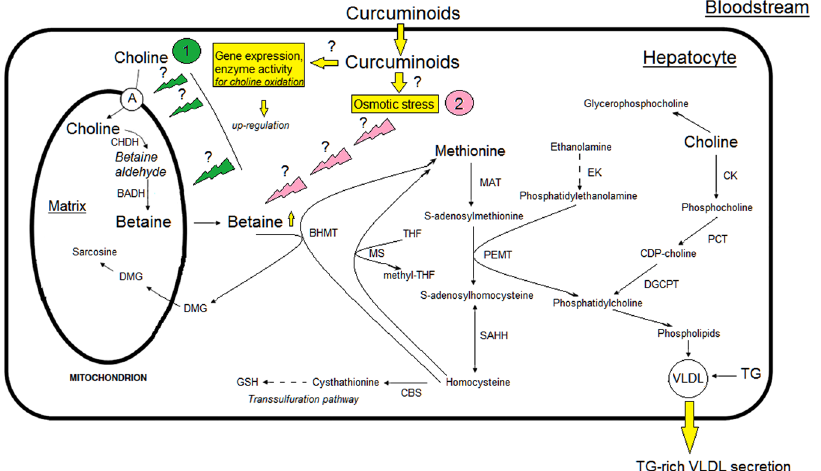
Figure 3. Overview of the metabolism of hepatic methylamine. (1) Choline oxidation pathway, the up regulation of gene expression and/or enzyme activity involved in this pathway. (2) Osmotic stress pathway by which curcuminoids might downregulate the BHMT enzyme activity in liver leading to high level of betaine. Choline transporter (A); choline dehydrogenase (CHDH); betaine aldehyde dehydrogenase (BADH); betaine homocysteine methyltransferase (BHMT); cystathionine β -synthase (CBS); choline kinase (CK); 1,2 diacylglycerol choline phosphotransferase (DGCPT); dimethylglycine (DMG); ethanolamine kinase (EK); methionine adenosyltransferase (MAT); methionine synthase (MS); phosphocholine cytidylyltransferase (PCT); phosphoethanolamine N-methyltransferase (PEMT); S-adenosylhomocysteine hydrolase (SAHH); tetrahydrofolate